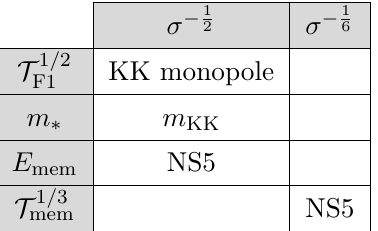
Table 9 . Asymptotic mass scalings along CS flow Im τ 1 ∼ σ → ∞ .